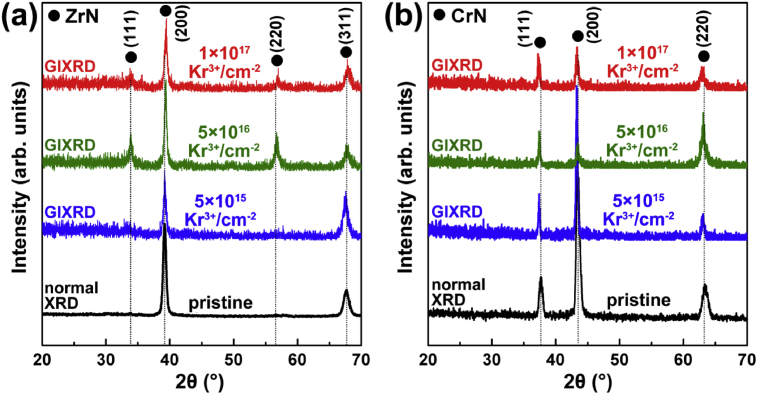
The XRD patterns of the (a) ZrN and (b) CrN coatings after the ion irradiation. The black curves indicate the normal diffraction patterns of the as-deposited coatings. The blue, green and red curves correspond to the GIXRD patterns of the coatings after the 5×1015, 5×1016 and 1×1017 Kr3+/cm−2 irradiation, respectively.